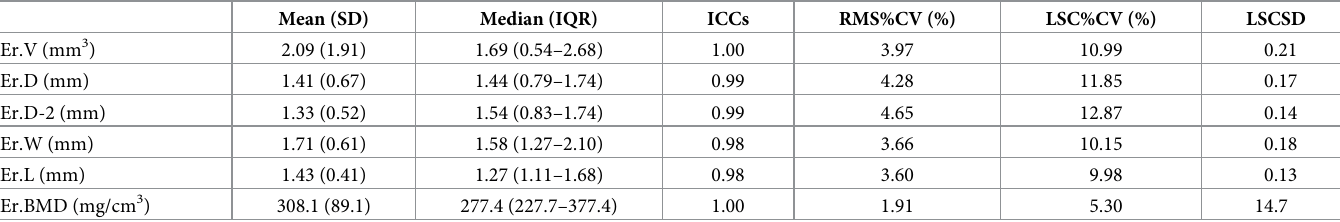
Table 1. Measurement reproducibility of each erosion parameter.